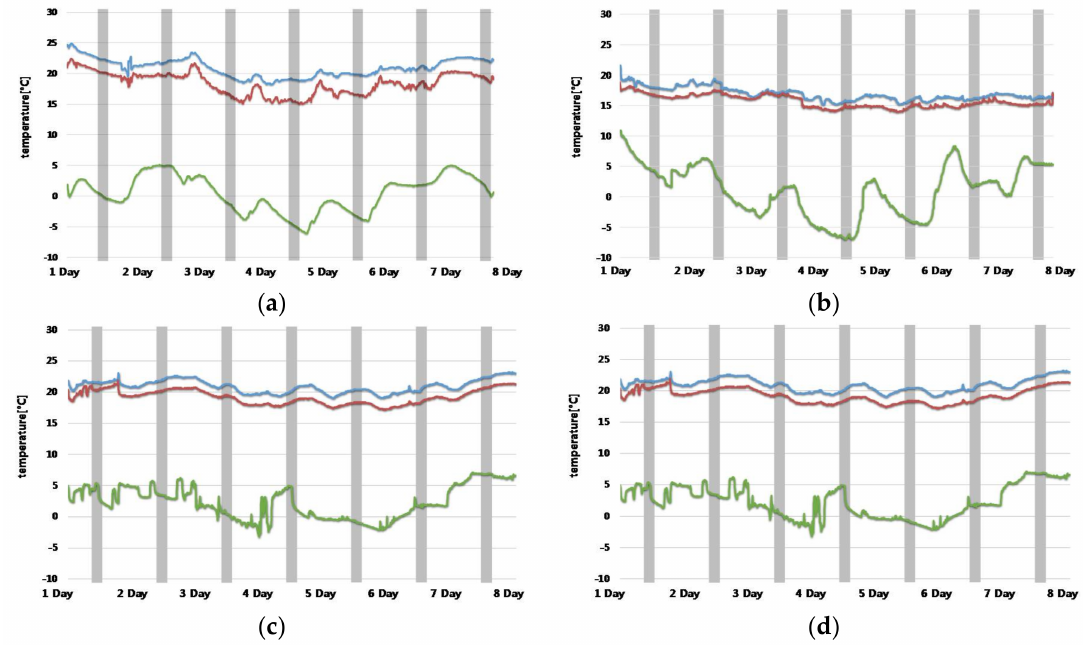
Figure 7. Value of the temperature measured by the ASTR method ( a ) Case A; ( b ) Case B; ( c ) Case C; ( d ) Case D; the internal air temperature (blue); the internal surface temperature of the wall (red); external air temperature (green); 02:00–06:00 a.m.; quasi-steady state zone (black